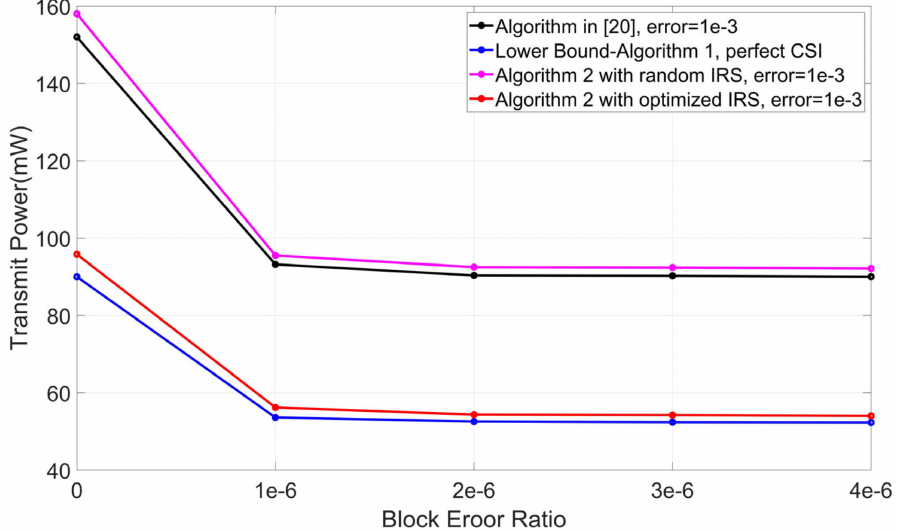
Figure 8. The effectiveness of the proposed algorithm under different numbers of the